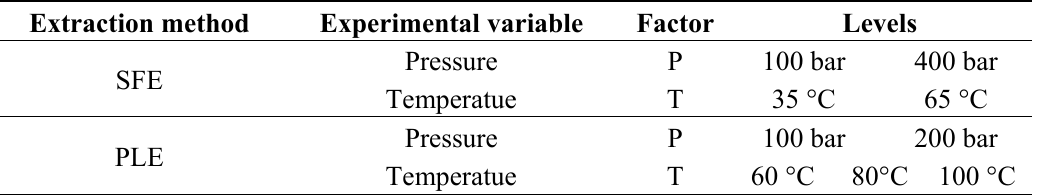
Table 4. Physical values in the experimental